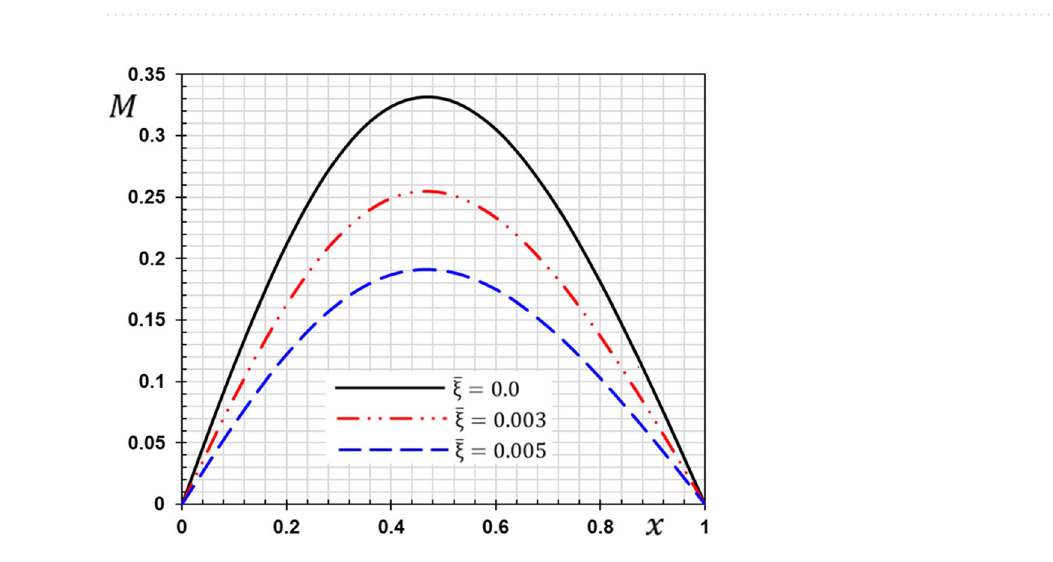
Figure 4. The displacement u with the non-local parameter ξ .